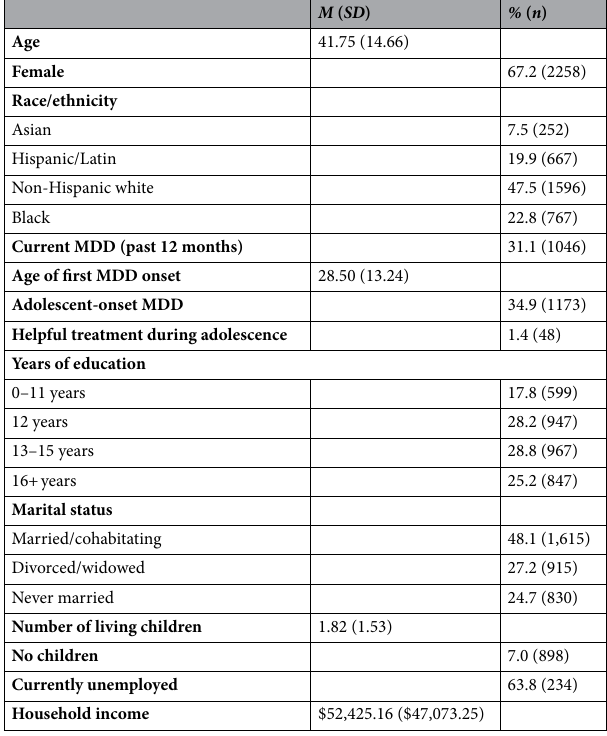
Table 1. Characteristics of NCS participants with a history of depression ( n =